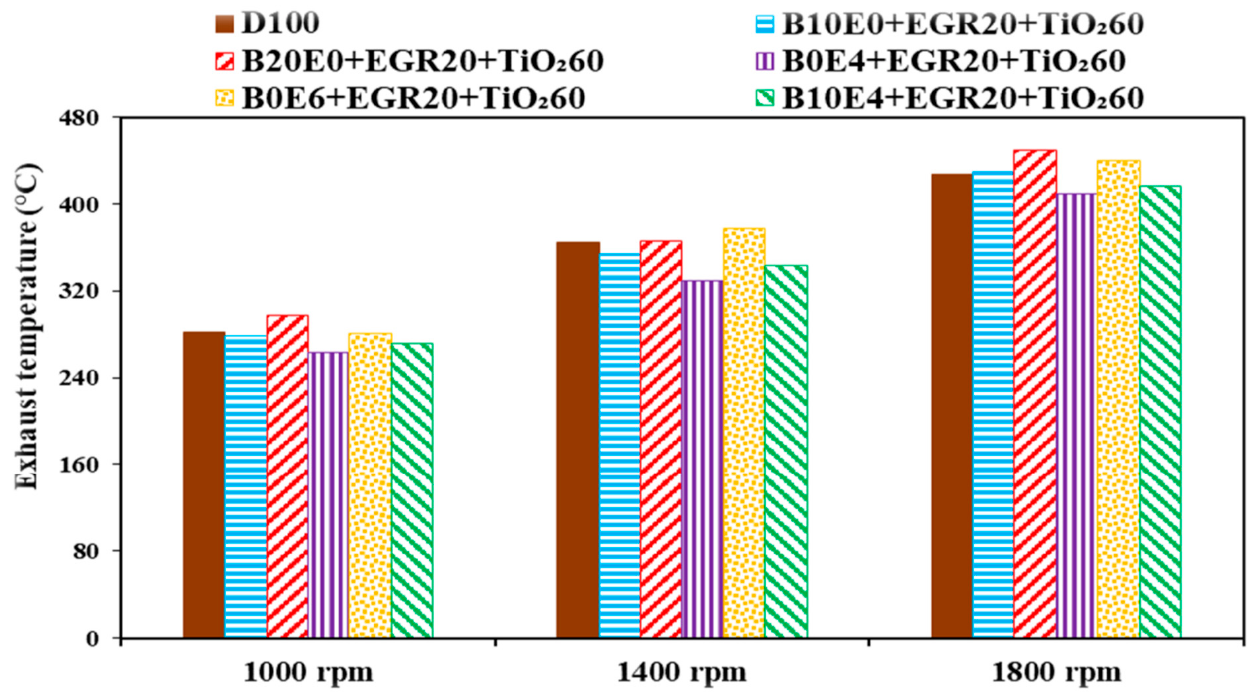
Figure 9. Variation of exhaust temperature for diesel/ethanol/biodiesel blends at EGR = 20%, TiO 2 = 60 ppm, and various engine speeds.